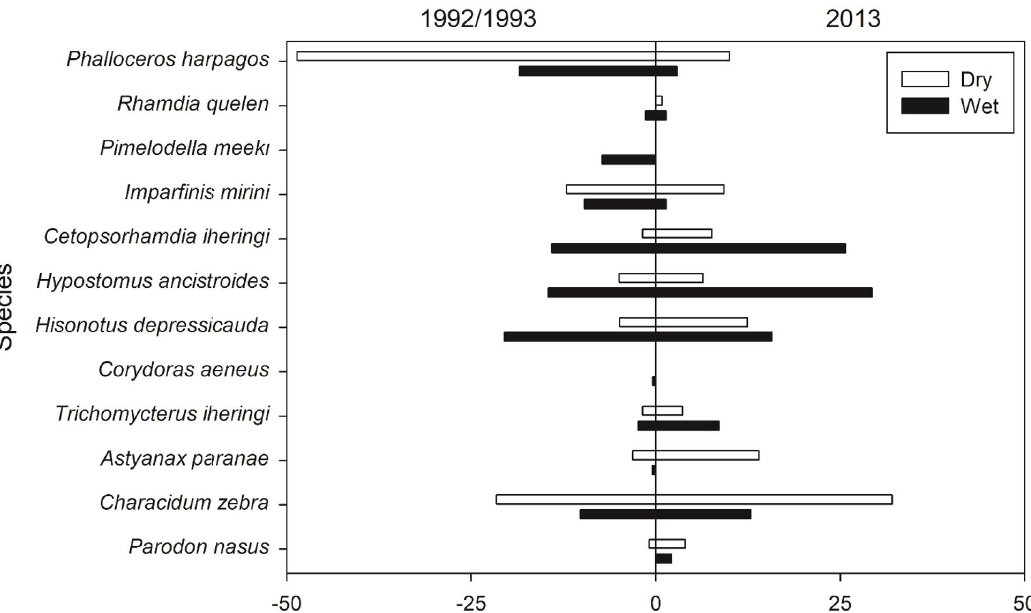
Figure 2. Relative abundance of the fish species sampled in the Capivara River, during the dry and wet season in the years 1992/1993 and 2013.